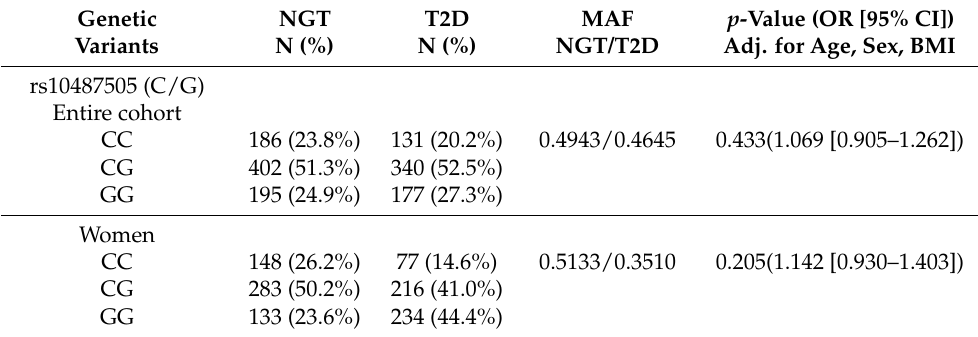
Table 2. Logistic regression between rs10487505 and occurrence of T2D in the additive model.